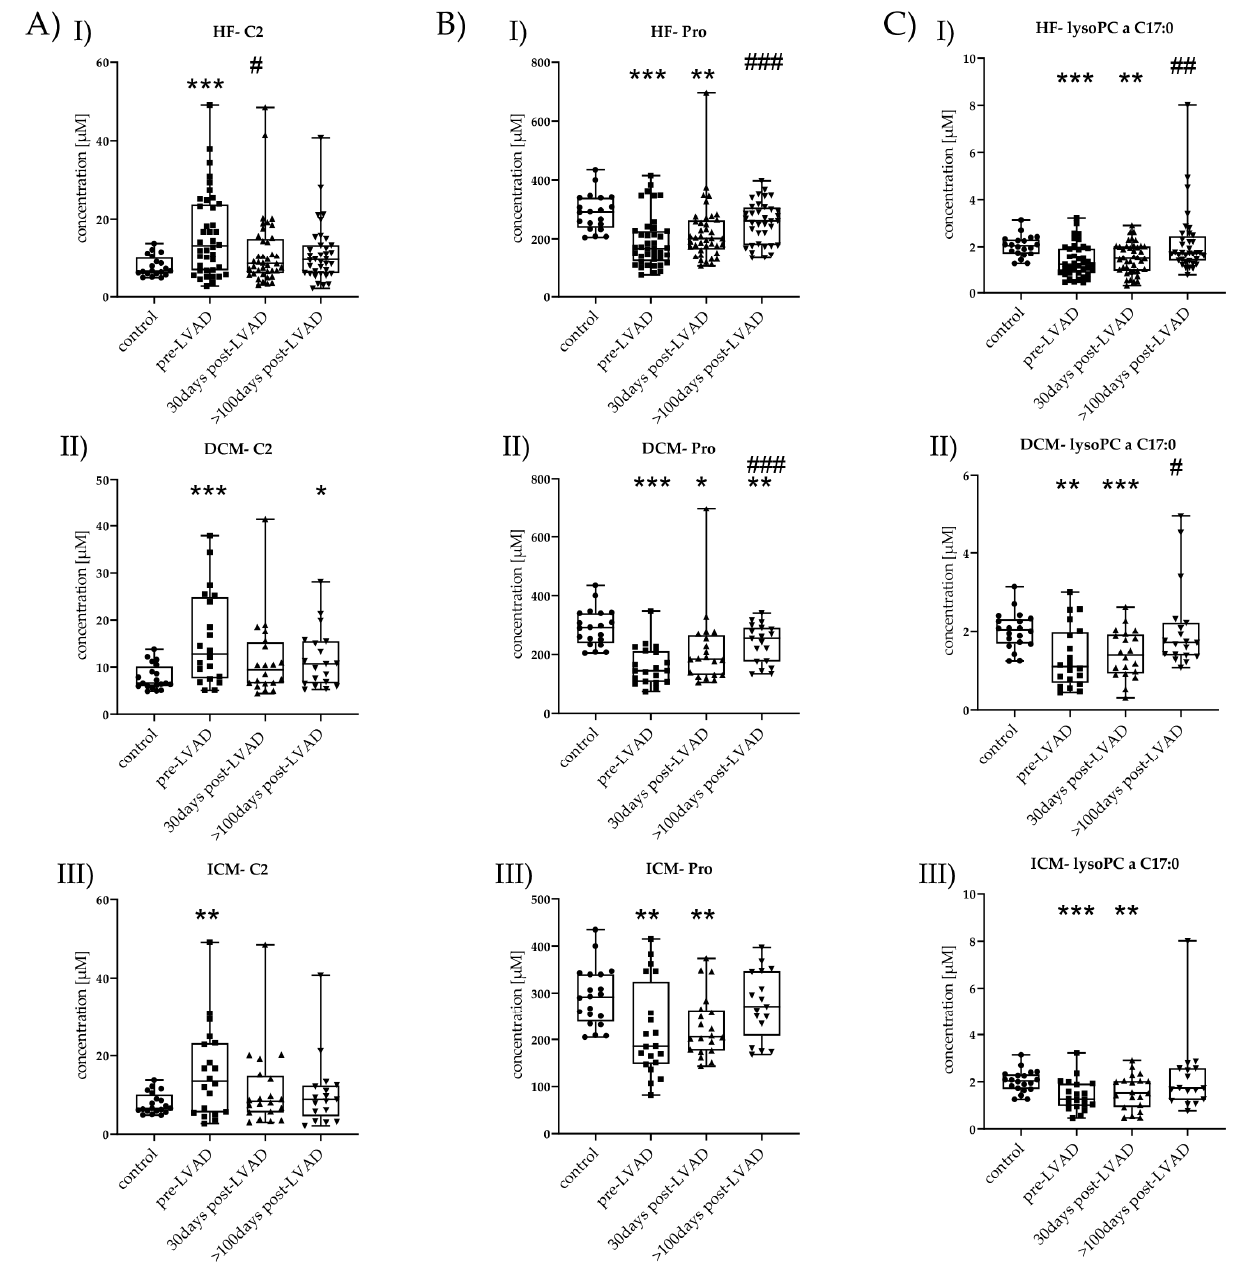
Figure 5. Time-course changes of C2, Pro, and lysoPC a C17:0 in HF, DCM, and ICM. ( A ) I–III C2 levels of control vs. HF, DCM, and ICM with pre-LVAD, 30 days post-LVAD, and >100 days post-LVAD. Depicted are min, max, median, and single values. Significance was calculated with a t -test or the Mann–Whitney U test * indicates significant to control (* = p < 0.05, ** = p < 0.01, *** = p < 0.001). # indicates significant to pre-LVAD (# = p < 0.05). ( B ) I–III Pro levels of control vs. HF, DCM, and ICM all with pre-LVAD, 30 days post-LVAD, and >100 days post-LVAD. Depicted are min, max, median, and single values. Significance was calculated with a t -test or the Mann–Whitney U test * indicates significant to control (* = p < 0.05, ** = p < 0.01, *** = p < 0.001). # indicates significant to pre-LVAD (### = p < 0.001). ( C ) I–III lysoPC a C17:0 levels of control vs. HF, DCM, and ICM all with pre-LVAD, 30 days post-LVAD, and >100 days post-LVAD. Depicted are min, max, median, and single values. Significance was calculated with a t -test or the Mann–Whitney U test * indicates significant to control (** = p < 0.01, *** = p < 0.001). # indicates significant to pre-LVAD (# = p < 0.05, ## = p < 0.01)